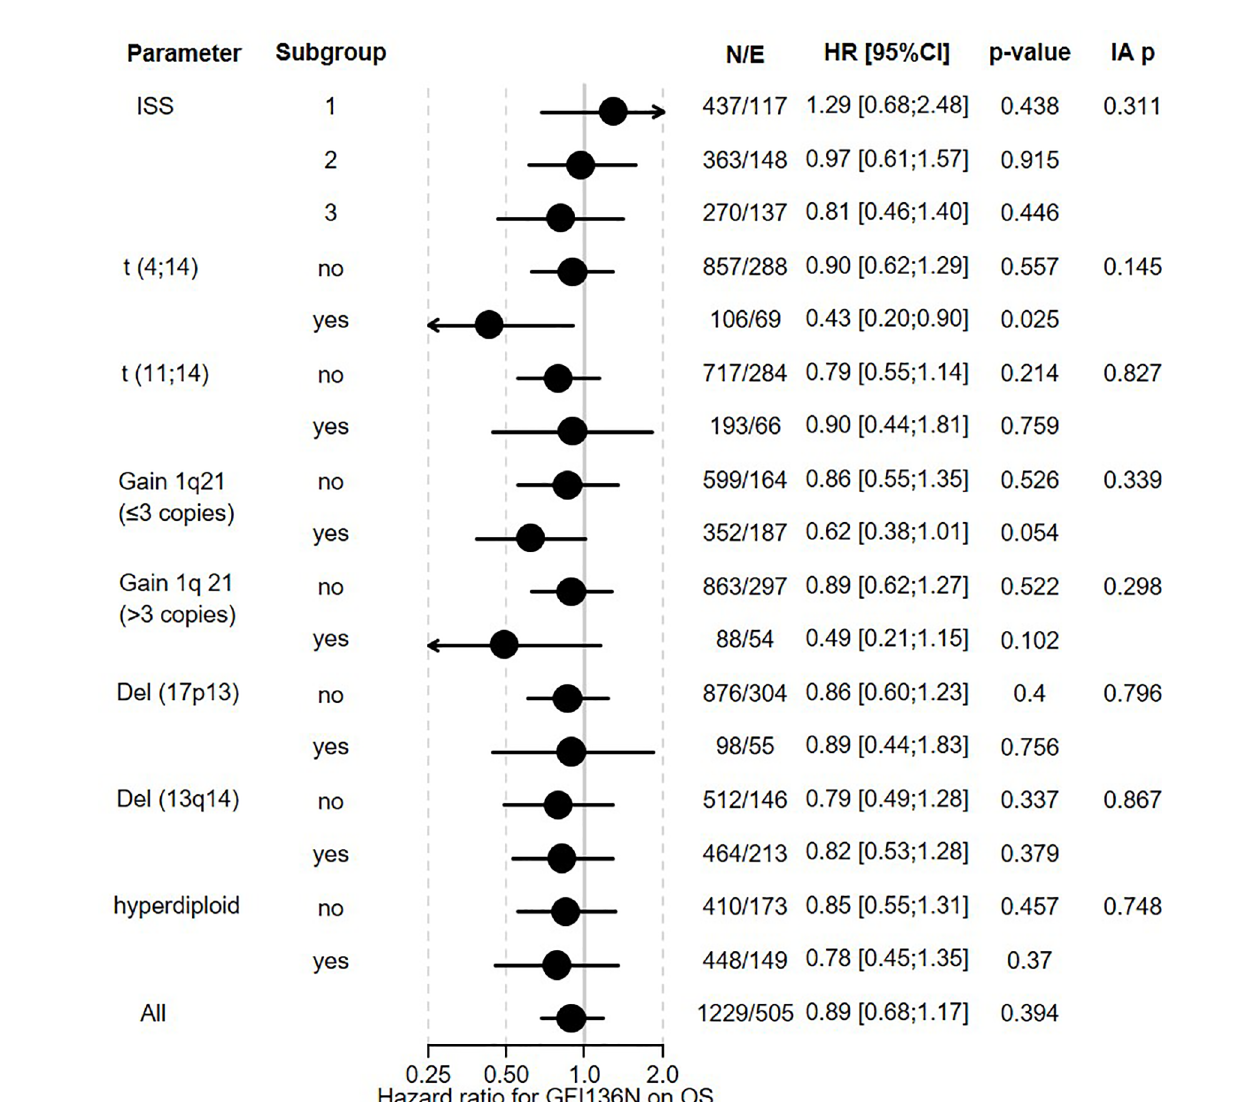
FIGURE 2 | In fl uence of GFI1-36N on OS of MM patients. GFI1-36N (homo or heterozygous) MM patients were strati fi ed according to presence/absence/levels of different parameters, International Staging System (ISS), t(4;14), t(11;14), gain 1q21 ( ≤ 3 copies), or gain 1q21 (>3 copies), Del (17p13), Del (13q14), hyperdiploid and statistically evaluated for PFS. Hazard ratio including 95% con fi dence interval based on Cox regression is presented. IA p indicates test on the interaction between subgroups, N/E: Number of patients and events within the